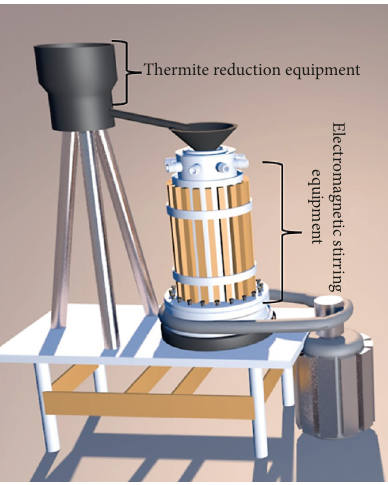
Figure 23: The applied magnetic field stirring equipment